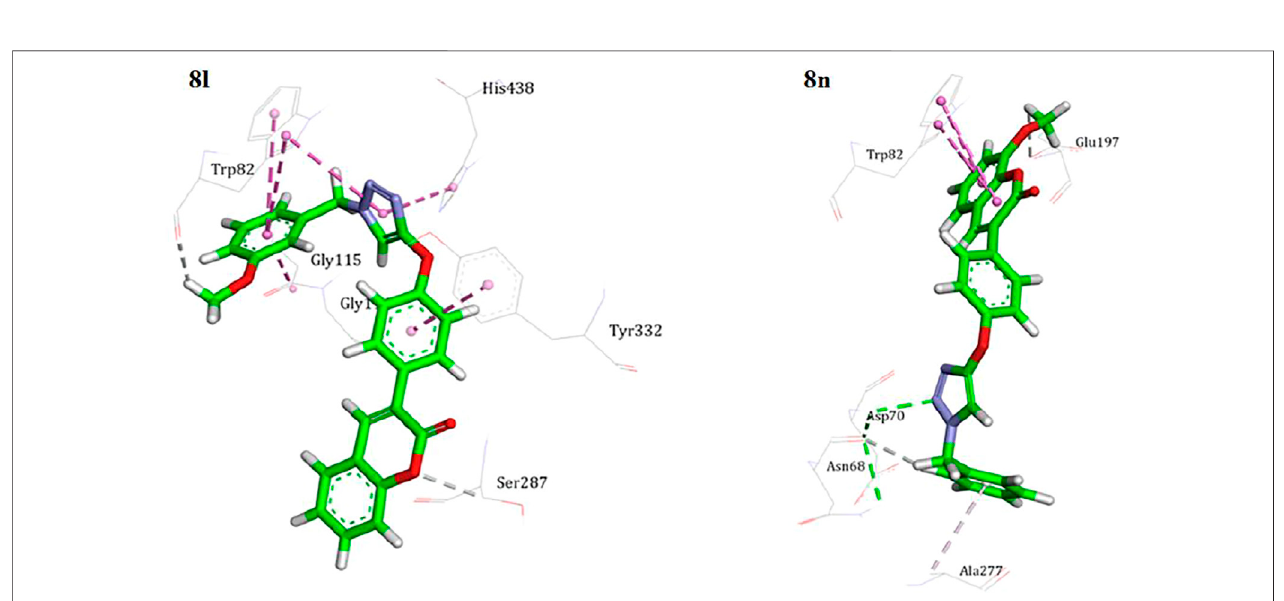
FIGURE 3 | Binding mode of compounds 8l and 8n into the active site of BuChE.